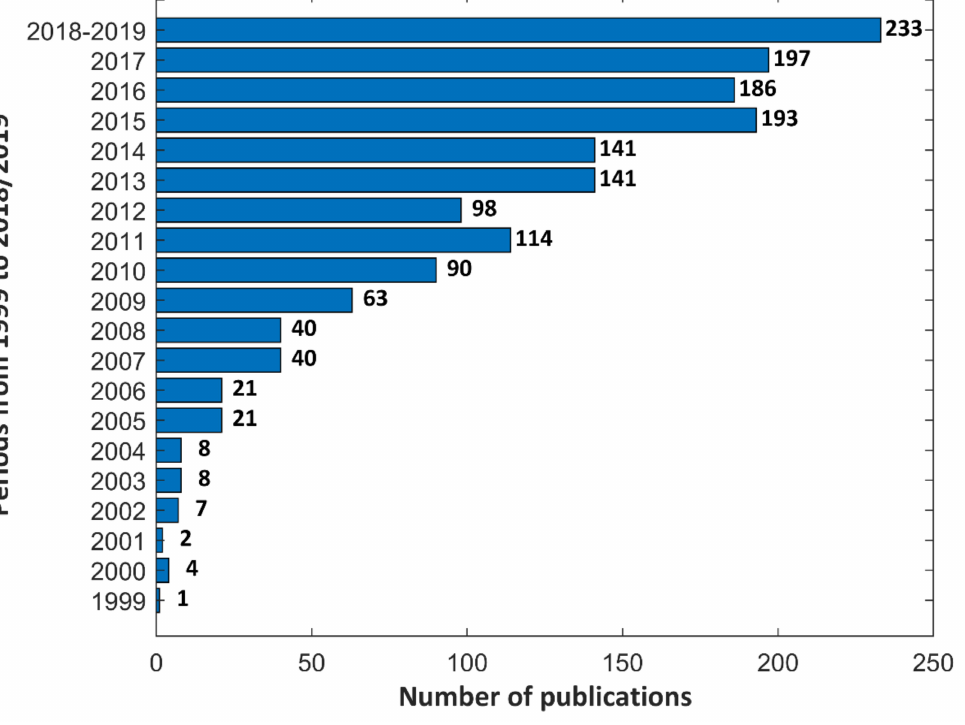
Figure 1. Number of publications based on www.sciencedirect.com in